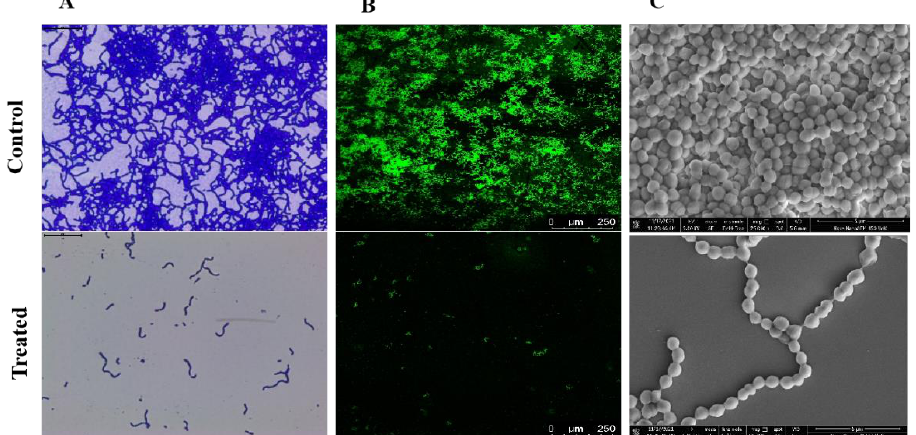
Figure 4. Microscopic visualization of Streptococcus pyogenes biofilm. ( A ) Light microscopic images (400×) representing Linalool’s inhibitory effect on biofilm microcolony formation. ( B ) CLSM images (200×) of the acridine orange-stained biofilm of S. pyogenes , showing a decrease in biofilm architecture formation on Linalool treatment. Scale bar 250 μm. ( C ) SEM images (25,000×) comparing the cell surface features of S. pyogenes biofilms produced in the presence and absence of Linalool (at its MBIC of 0.004%). Scale bars 5 μm.